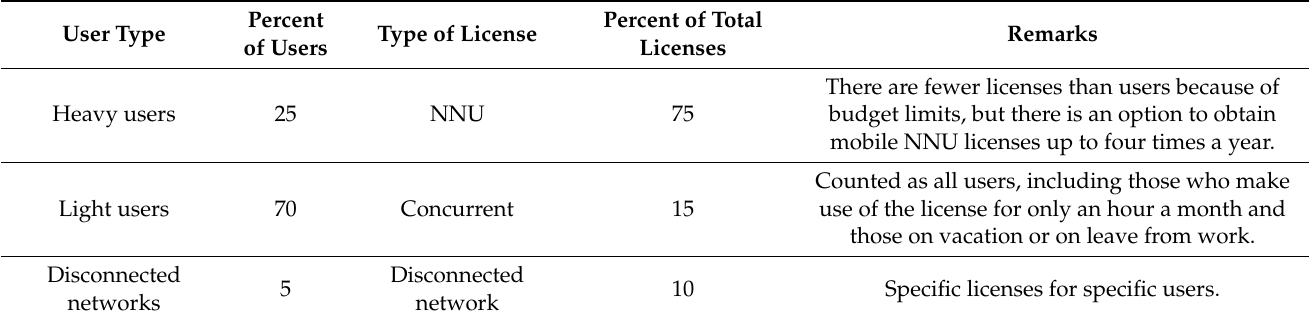
Table 1. Typical distribution of